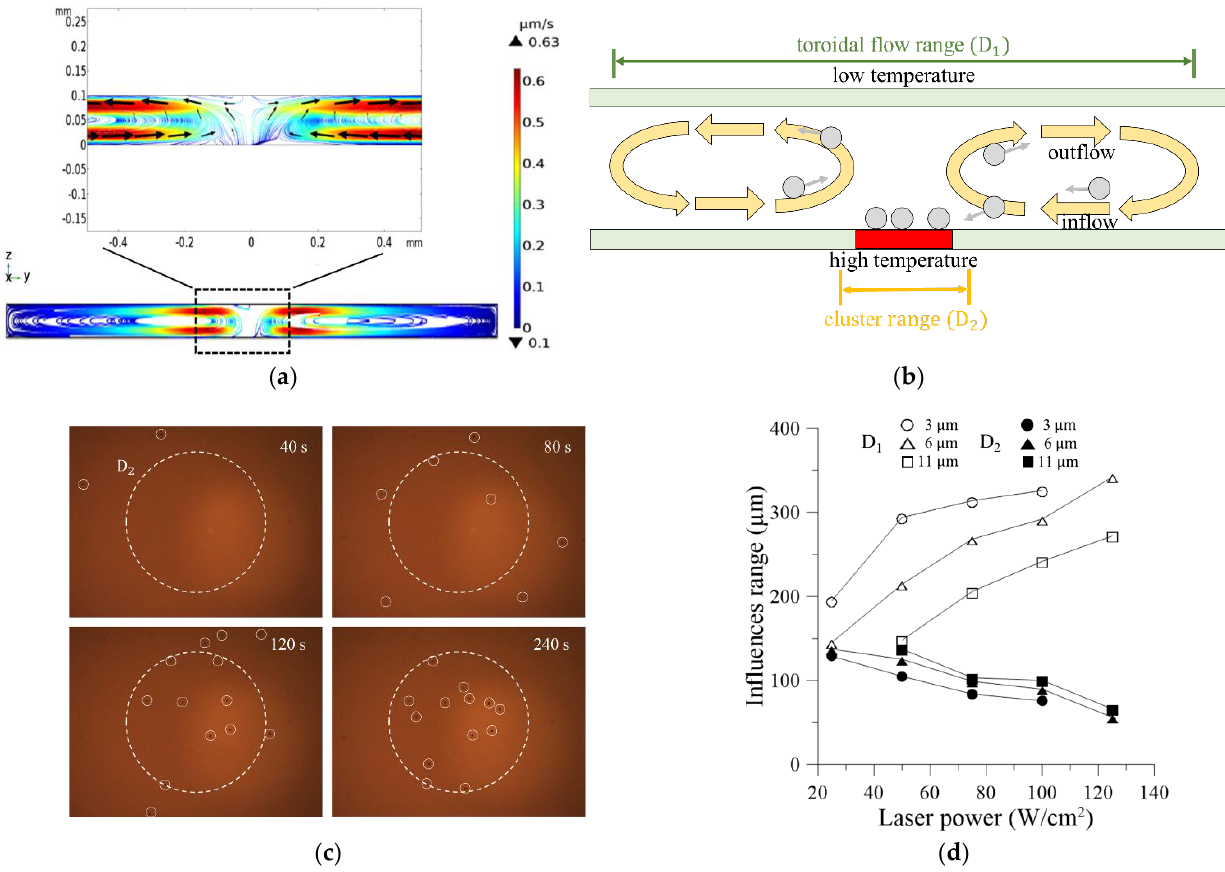
Figure 5. ( a ) Numerical contours and ( b ) schematic illustration showing flow range and clustering range of toroidal vortex structures induced by REP effect. ( c ) Experimental results for trapping of polystyrene beads with diameter of 3 μm at 40, 80, 120 and 240 s, respectively. ( d ) Variation of flow range and clustering range with laser power as function of particle size.